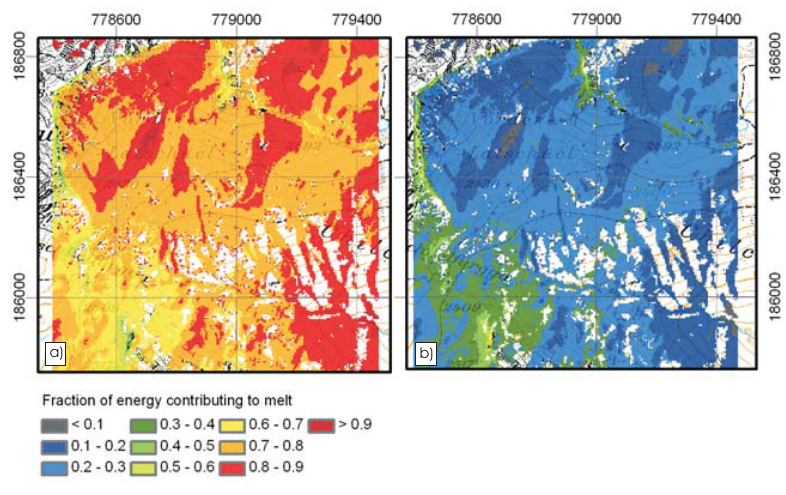
Fig. 5. Fractional energy contributing to snow melt during daytime of net radiation (a) and net turbulent energy (b) averaged for P3. of patchy snow covers early in the ablation season.